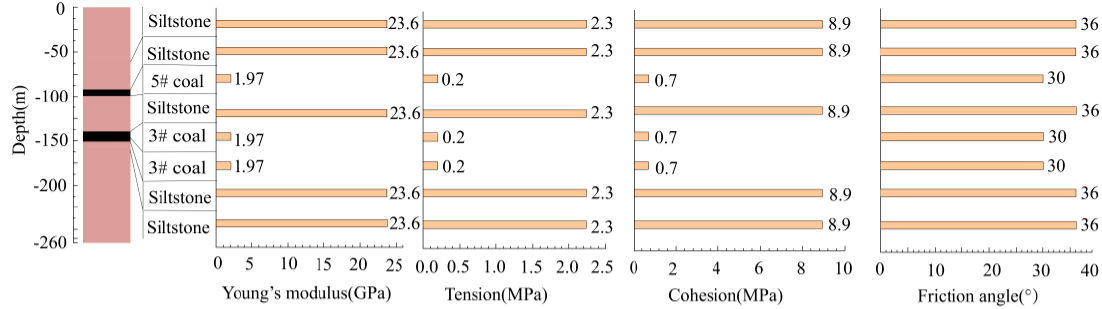
Figure 2. Simplified panel stratigraphy and geotechnical parameters of the seam, roof, and floor strata.